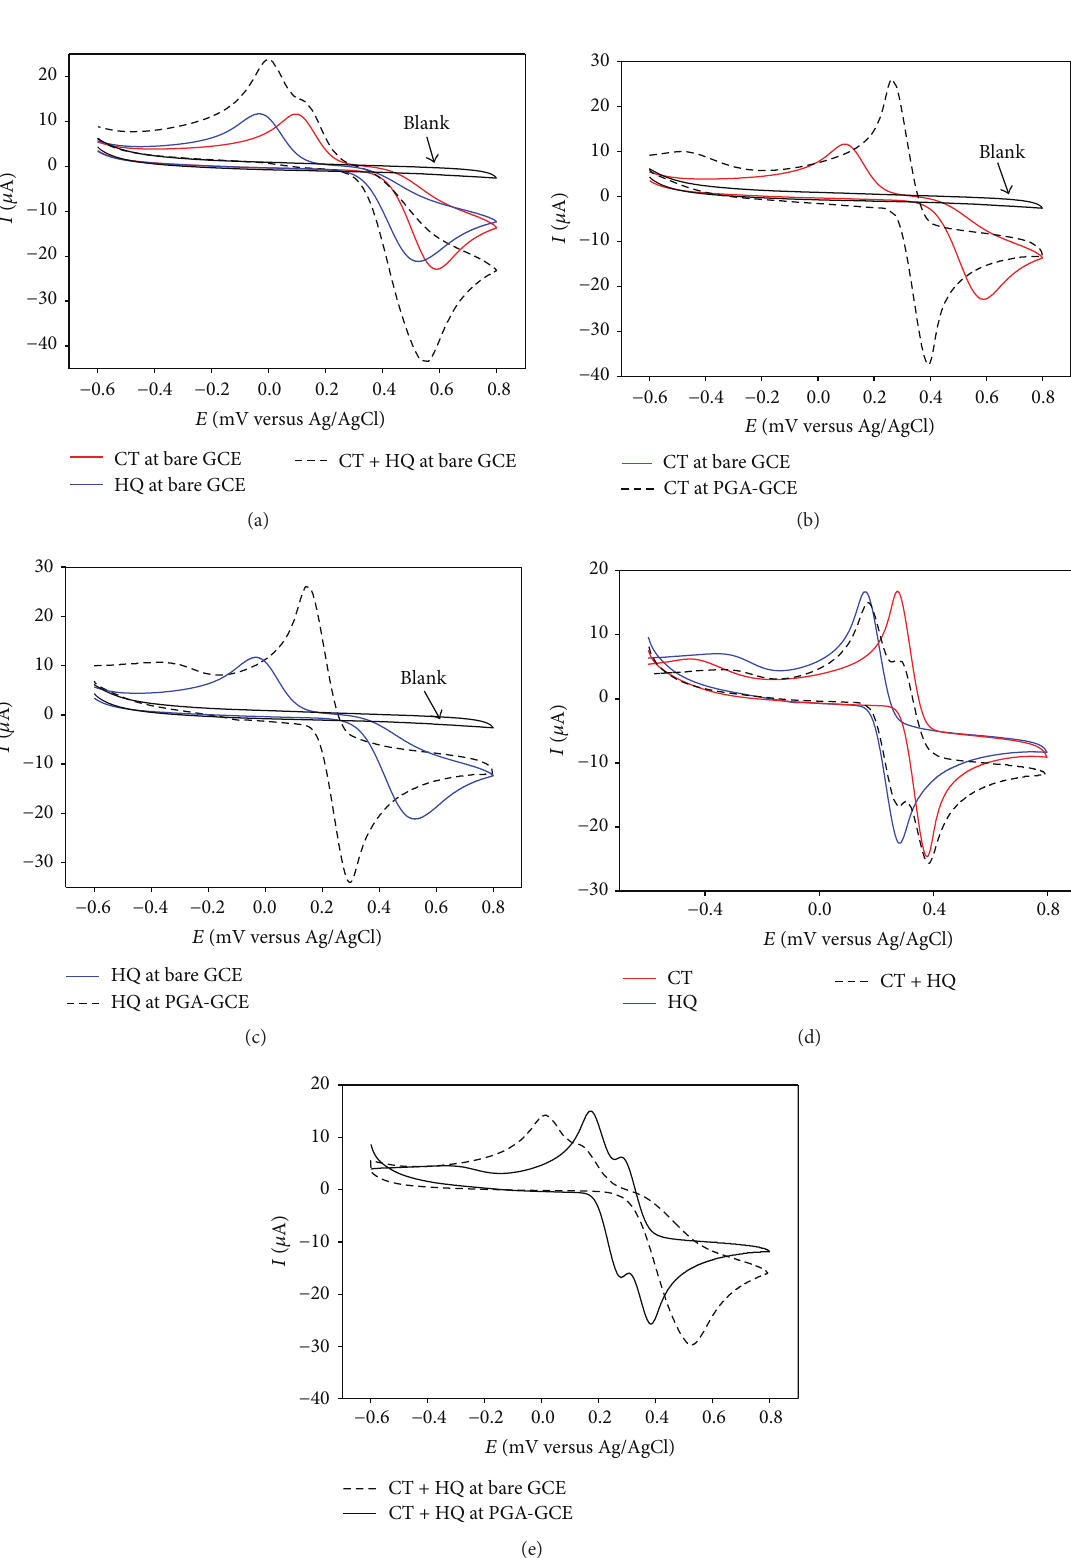
Figure 1: CVs of (a) CT and HQ (solid lines), CT-HQ binary mixture (dashed line) at bare GCE; (b) CT at bare GCE (solid line) and at PGA-GCE (dashed line); (c) HQ at bare GCE (solid line) and at PGA-GCE (dashed line); (d) overlay of individual CT and HQ (solid lines) and CT-HQ binary mixture (dashed line) at PGA-GCE; (e) comparison between simultaneous CT and HQ at bare GCE (dashed) and at PGA-GCE (solid line) in ABS pH